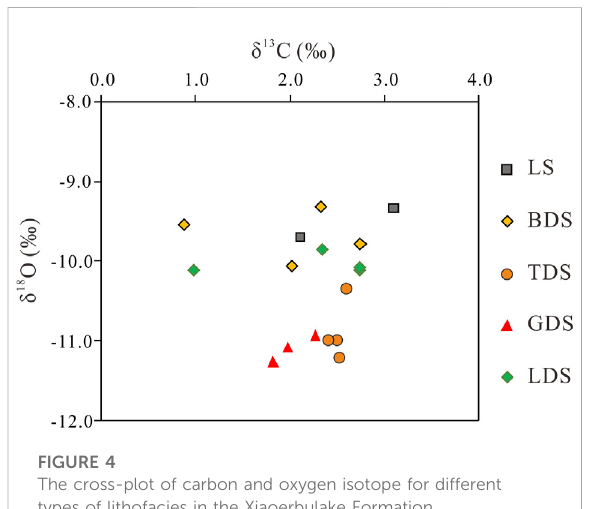
FIGURE 4 The cross-plot of carbon and oxygen isotope for different types of lithofacies in the Xiaoerbulake Formation.